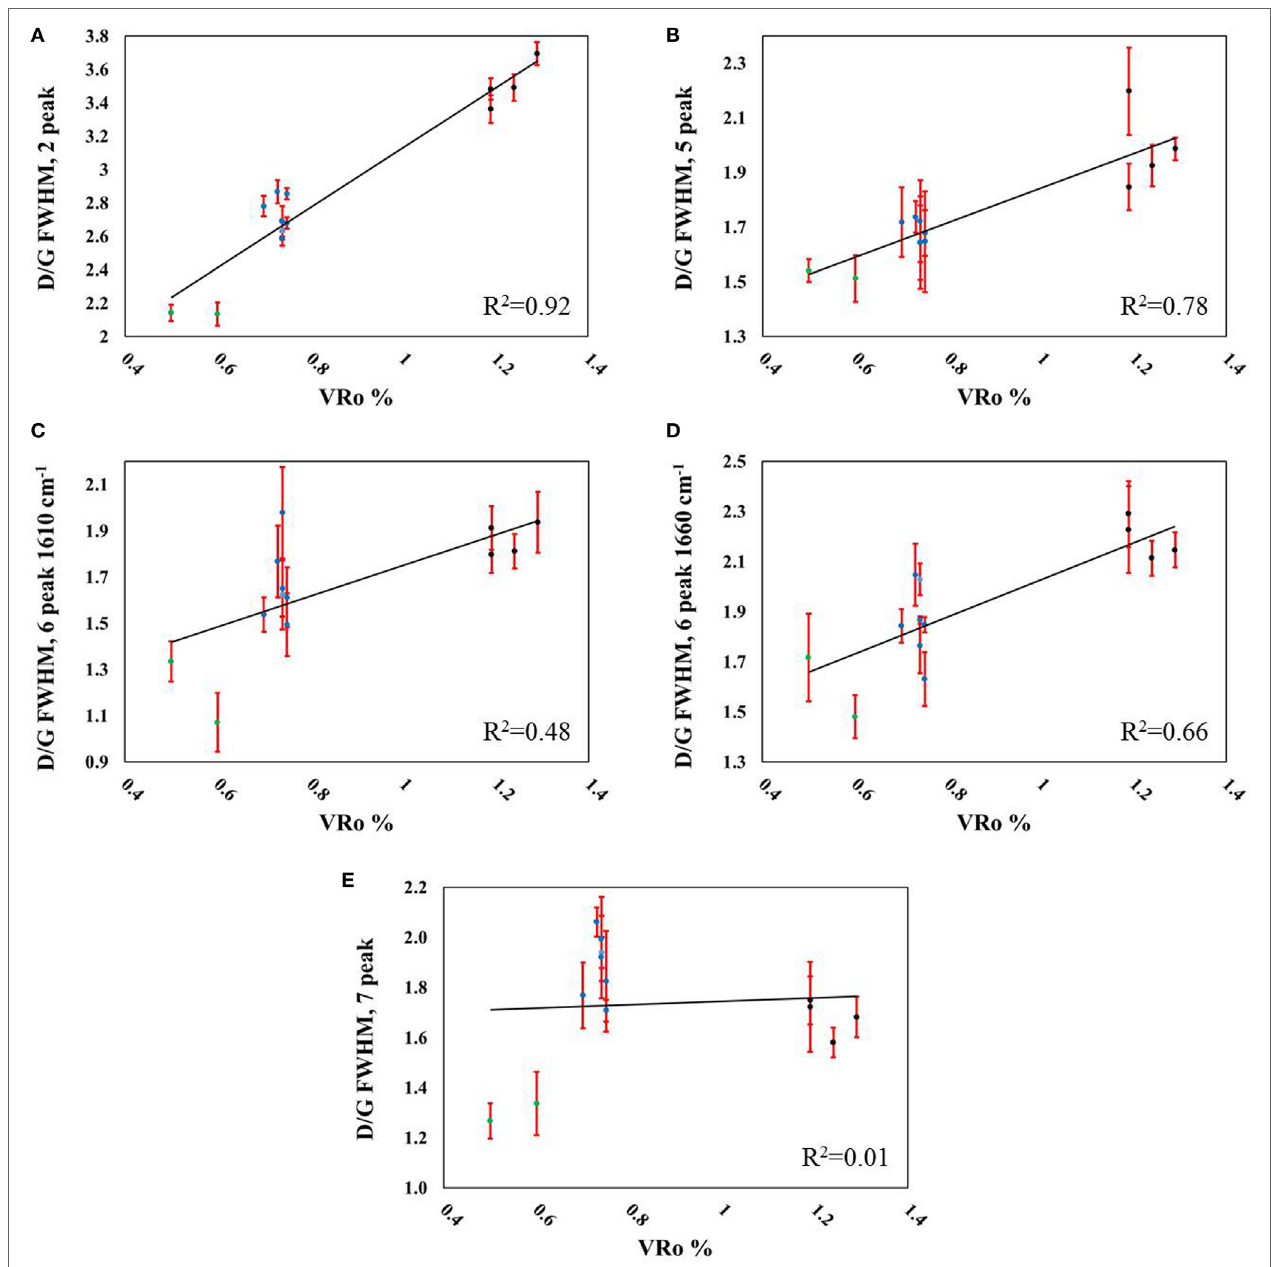
FigUre 8 | Correlations between D/G full width at half maximum (FWHM) and measured VRo% using (a) two peaks ( R 2 = 0.92), (b) five peaks ( R 2 = 0.78), (c) six peaks including the D2-band ( R 2 = 0.48), (D) six peaks including a ~1,660 cm − 1 peak ( R 2 = 0.66), and (e) seven peaks ( R 2 = 0.01). Data point legend: green = Aristech wells, blue = Interstate/Columbia wells, black = EQT